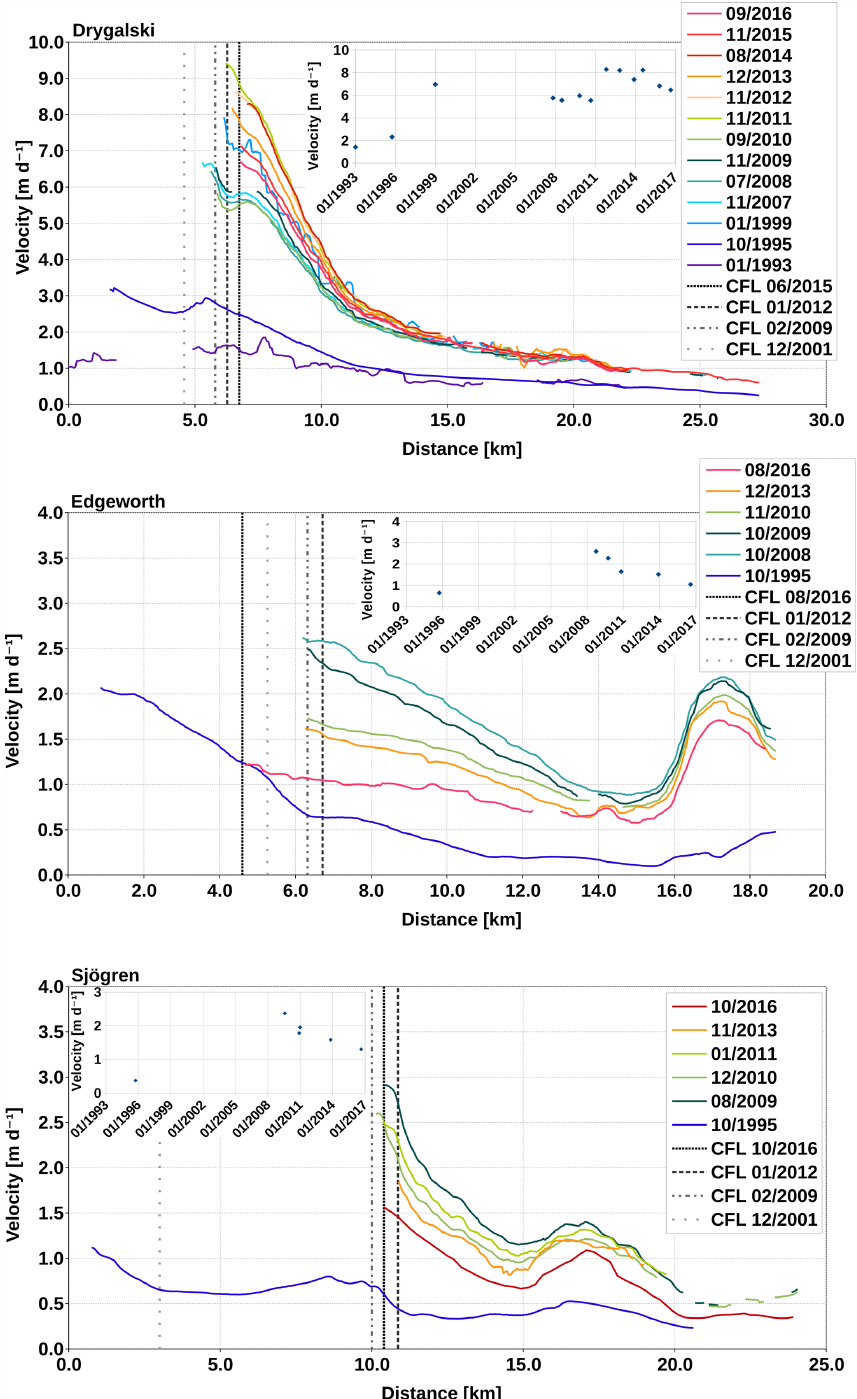
Figure 5. Surface velocities along the central flow lines of Drygalski, Edgeworth and Sjögren glaciers and their frontal positions on different dates (month/year). The x and y scales are different for individual glaciers. Vertical lines show positions of the calving front. The insets show velocities in the centre of the flux